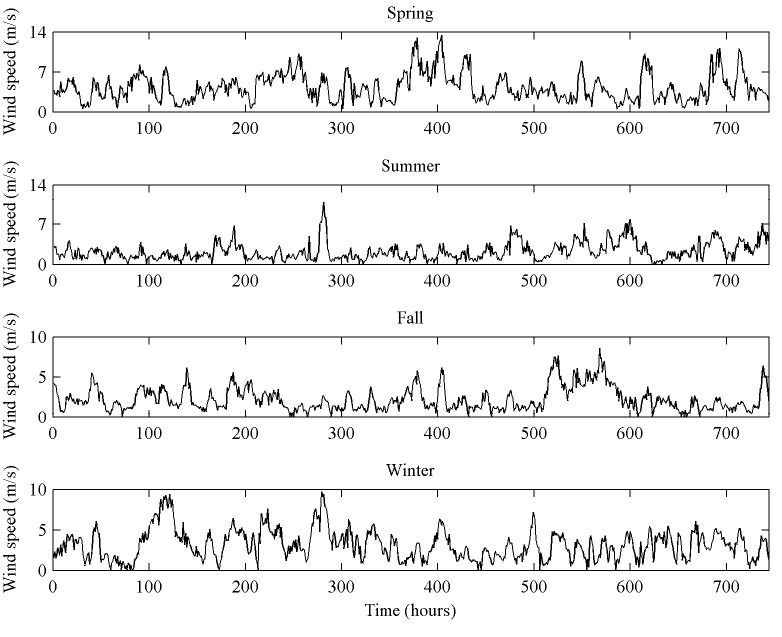
Figure 3. Four original wind speed cases. Table 1. Statistical measures of four cases.